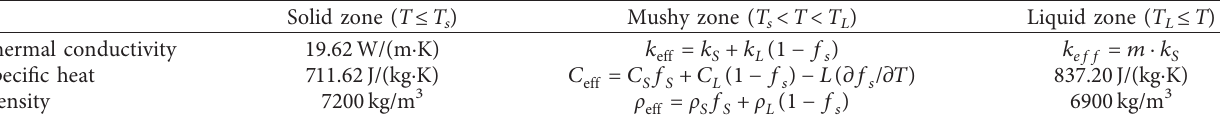
Table 3: Thermophysical parameters.